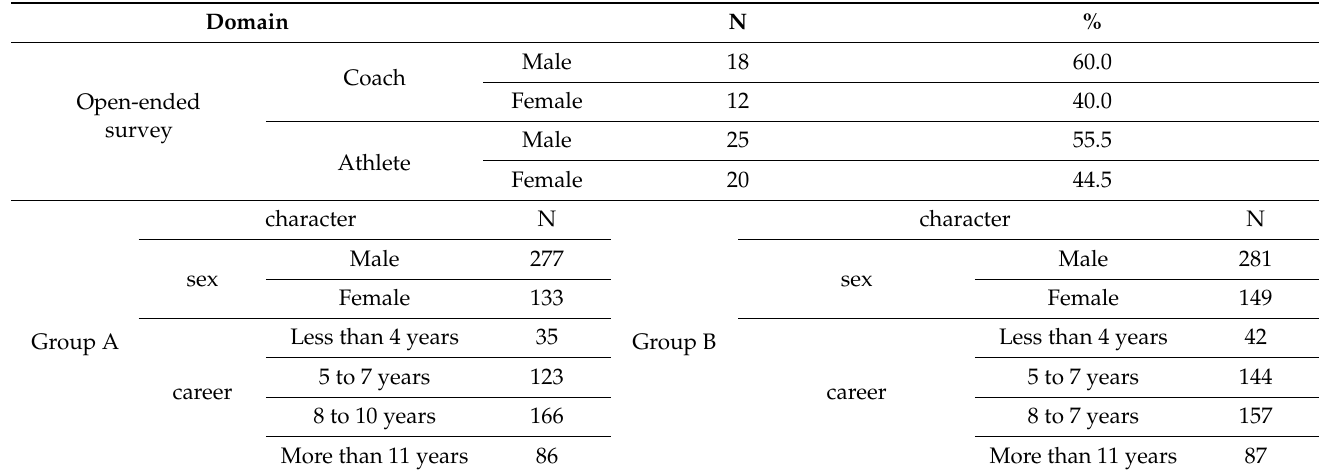
Table 2. General Characteristics of the Survey